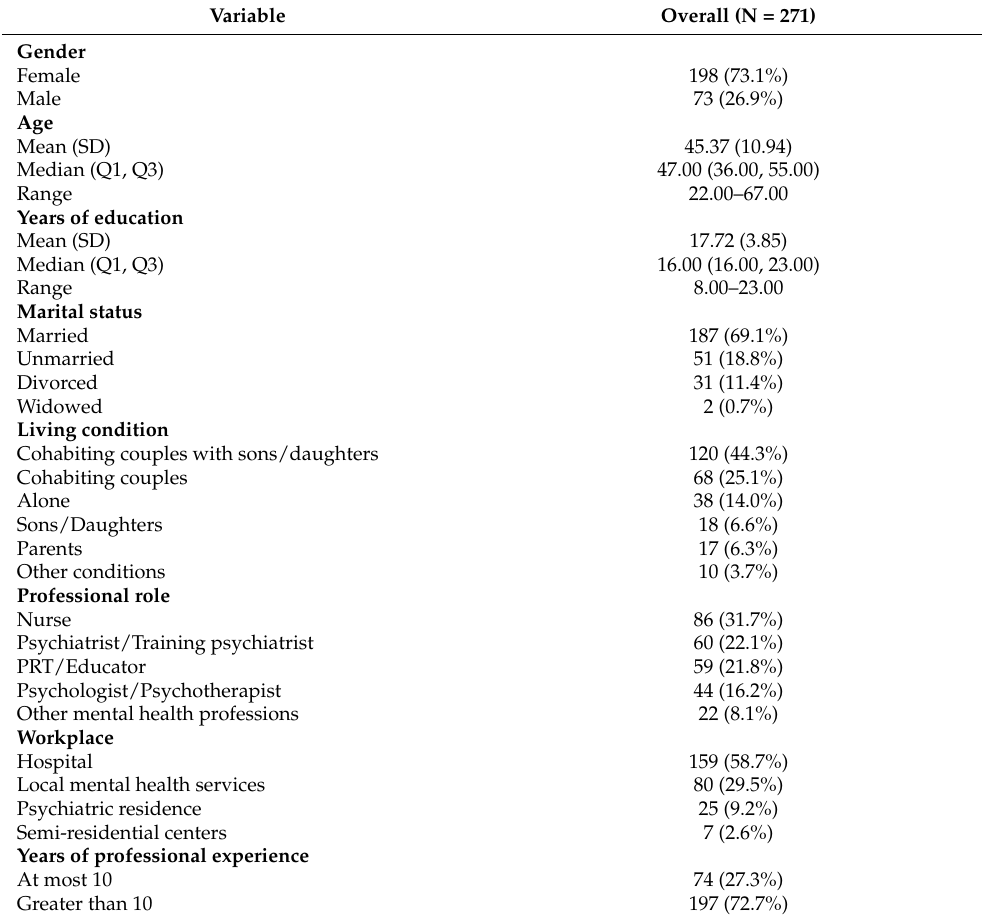
Table 1. Descriptive statistics on demographical and professional